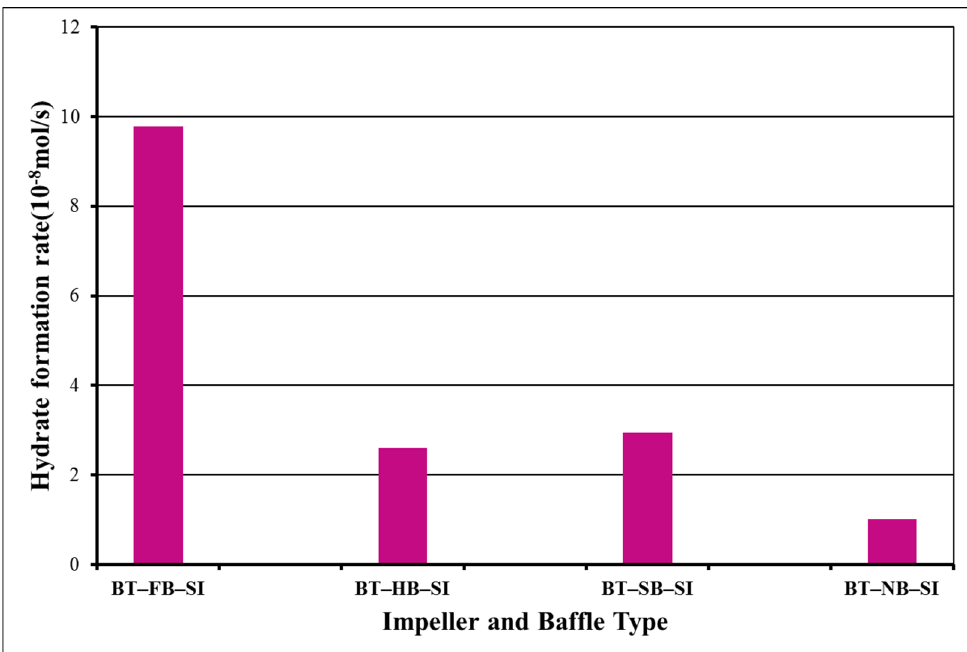
Figure 9. Hydrate formation rate constant in dual ‐ impeller experiments.